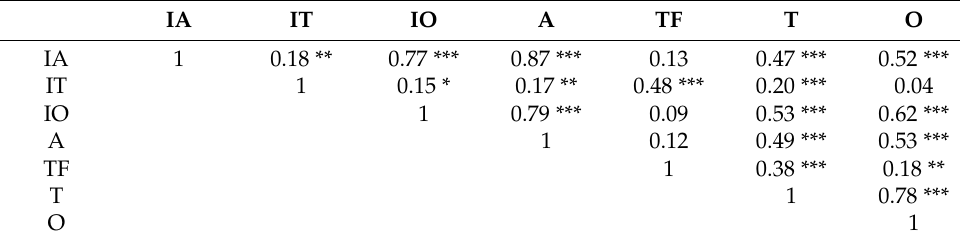
Table 6. Pearson correlation coefficients of sensory attributes across combined commodities. IA IT IO